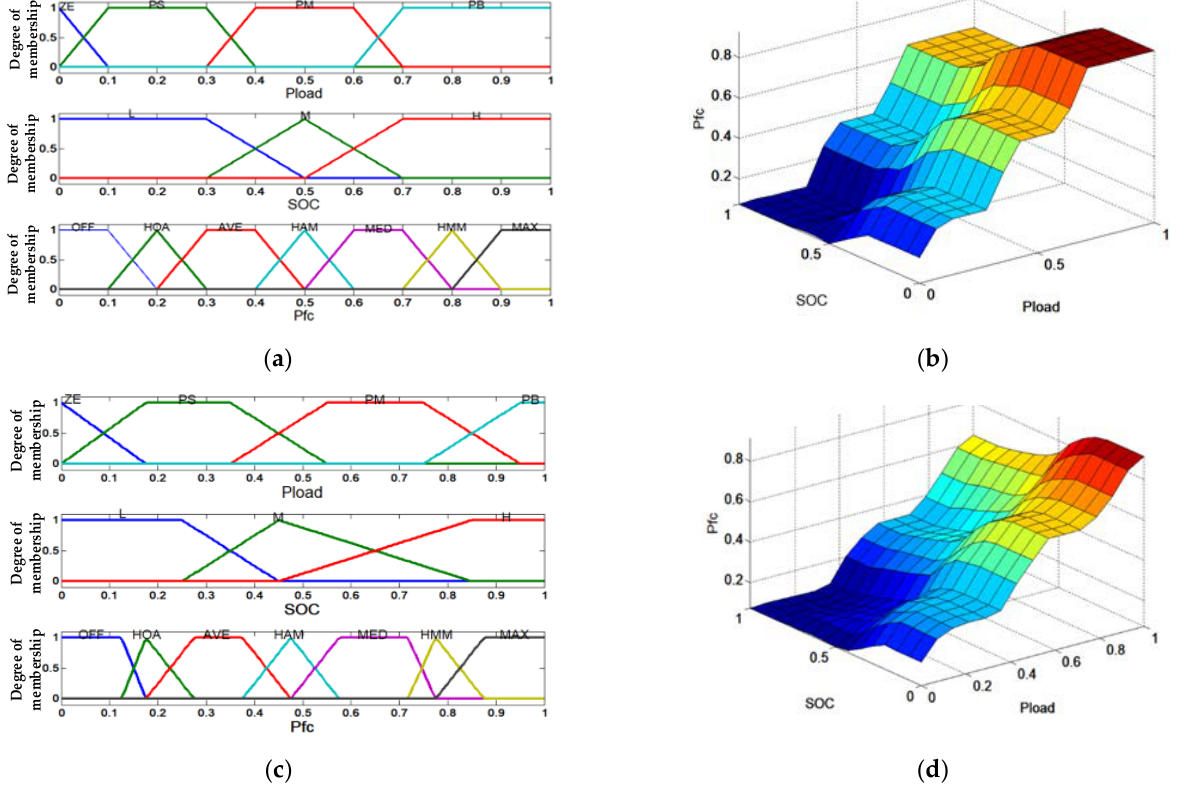
Figure 14. The difference of the Fuzzy logic controller between optimized by PSO and without PSO. ( a ) The membership of the FL algorithm. ( b ) The output surface diagram of fuel cells under the FL algorithm. ( c ) The membership of FL control with PSO. ( d ) The output surface diagram of FC under optimal FL control with PSO.